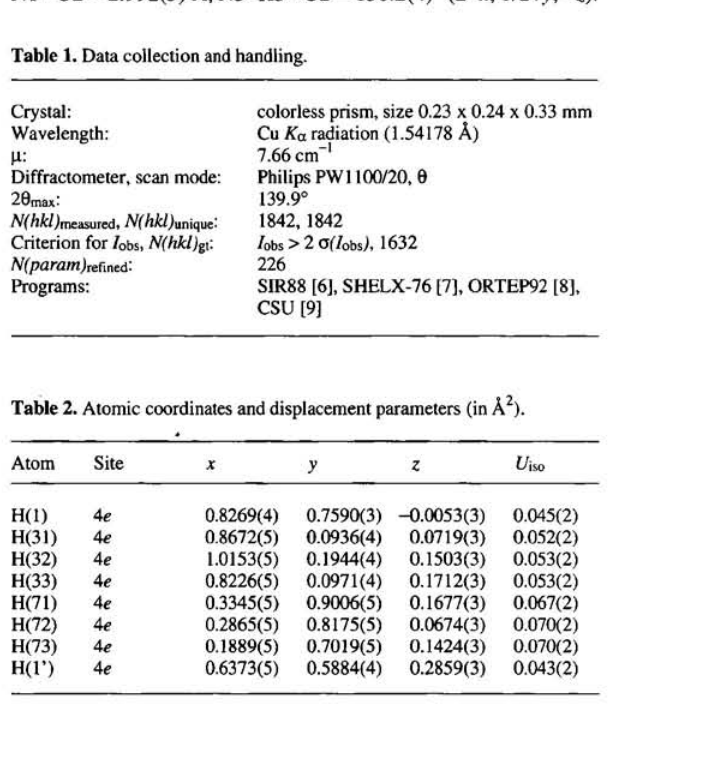
Table 1. Data collection and handling.